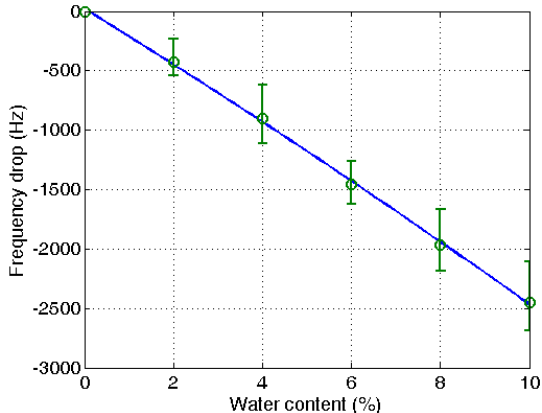
Figure 6. Relationship between water content and resonant frequency shift of PVA-coated quartz crystal